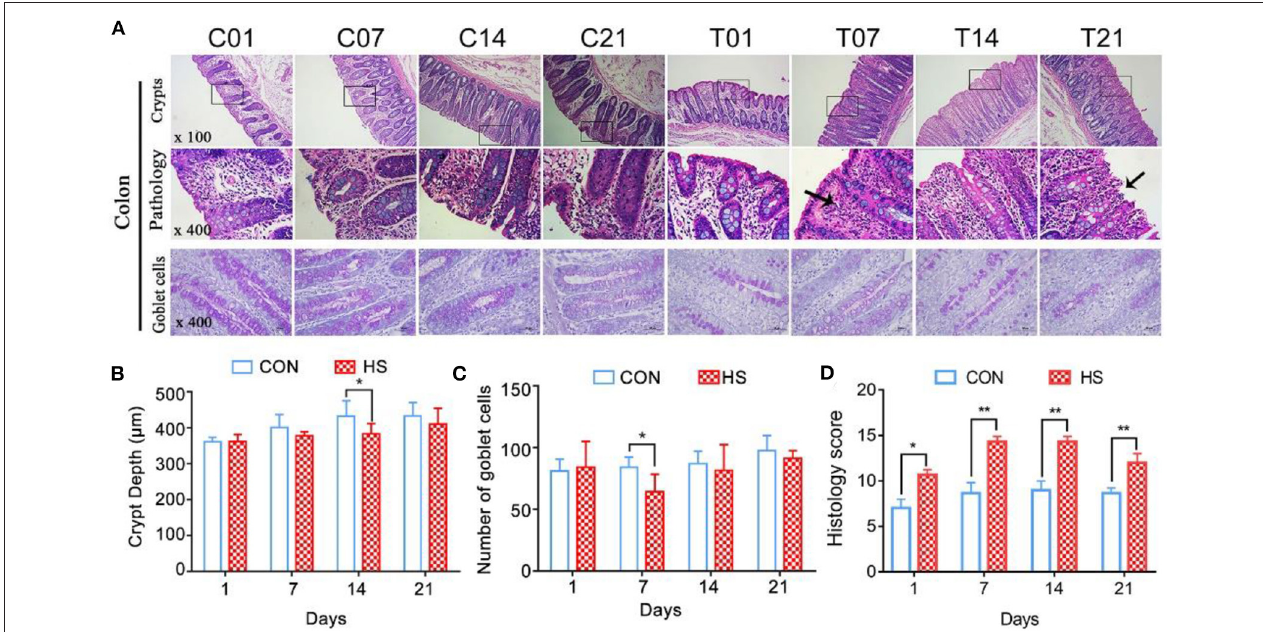
FIGURE 3 | Effects of heat stress on colonic mucosal structure in pigs. (A) Crypt histopathology (H&E and PAS staining), (B) colon crypt depth ( µ m), and (C) number of PAS-positive cells per mm 2 colonic mucosa; (D) Histology score. C and T refer to control- and HS pigs, respectively. The numbers 1, 7, 14, 21 indicate dates of sample collection. * p < 0.05, ** p < 0.01 compared with each